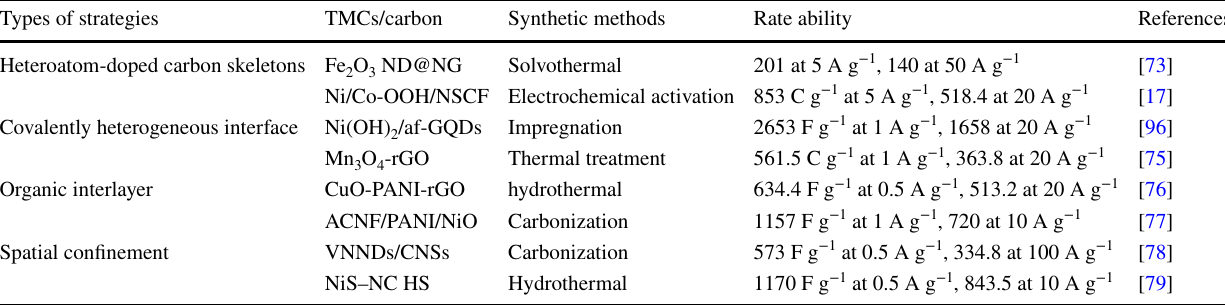
Table 2 Comparison of different interfacial strategies Types of